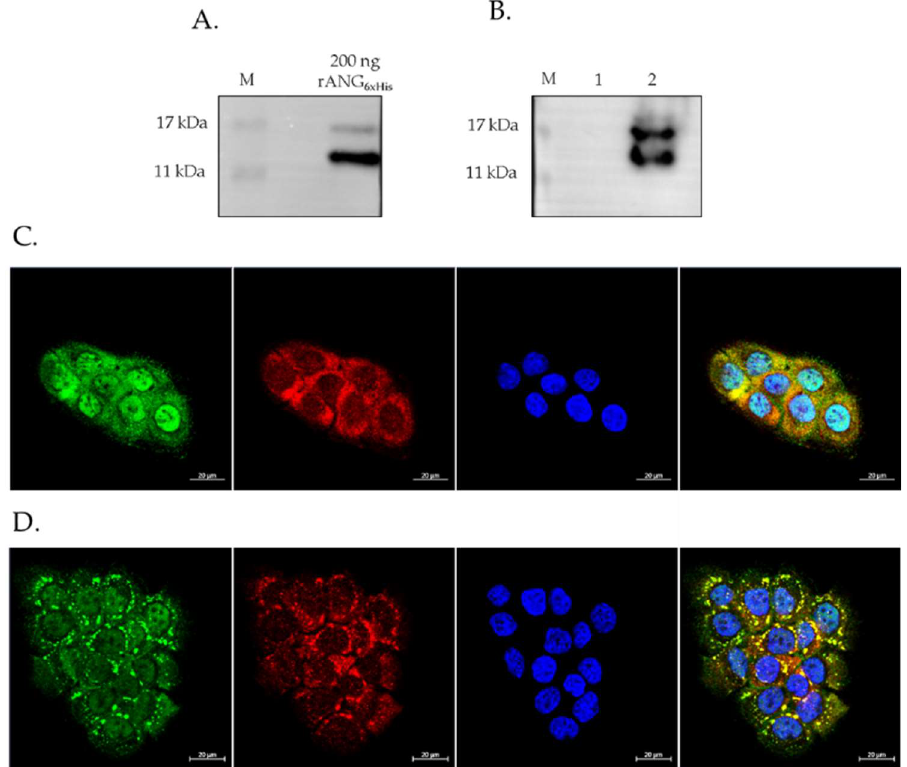
Figure 10. rANG 6xHis internalization and localization in HaCaT cells. (A ) Western blot analysis of 200 ng of purified rANG 6xHis used for cells treatments; ( B ) Western blot analysis of cell lysates obtained by IMAC chromatography (M: protein ladder; 1: untreated HaCaT cell lysate; 2: 2 µM rANG 6xHis treated HaCaT cell lysate). ( C ) Immunofluorescence analysis of unstressed 2 µM rANG 6xHis pre-treated cells. ( D ) Immunofluorescence analysis of SA-stressed 2 µM rANG 6xHis pre-treated cells. PABP (red), rANG 6xHis (green) and blue staining (DAPI) for nuclei.